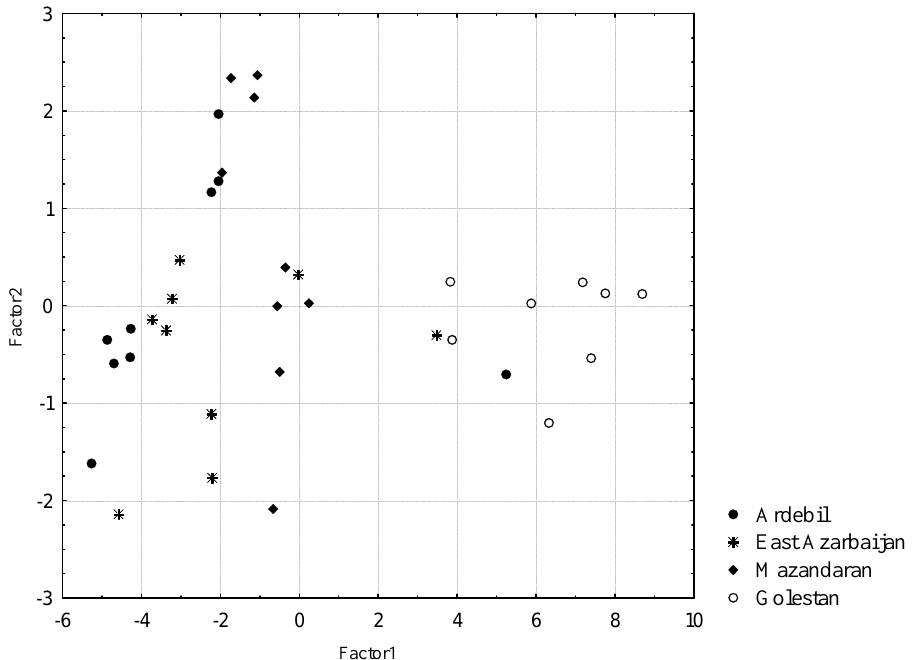
F IGURE 3. Emys orbicularis specimens of Ardeil, East Azerbaijan, Mazandaran and Golestan plotted in principle variant